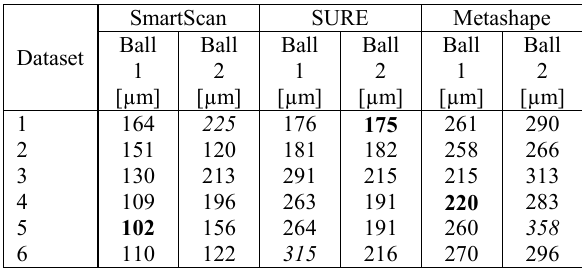
Table 4. Quality parameter probing error